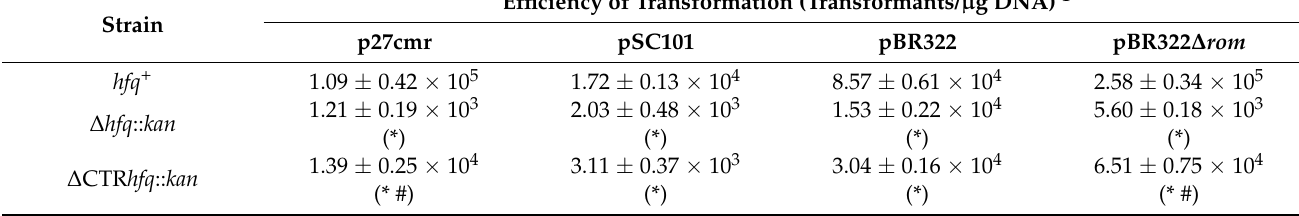
Table 3. Efficiency of transformation of E. coli hfq + , ∆ hfq :: kan and ∆ CTR hfq :: kan strains with plasmids p27cmr, pSC101, pBR322, and pBR322 ∆ rom . Efficiency of Transformation (Transformants/ µ g DNA) Strain